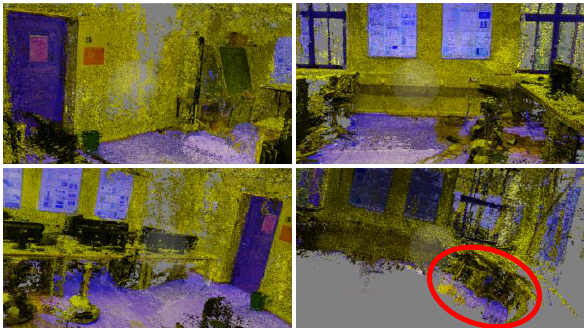
Figure 8. Excerpts from the generated point cloud using the three channel images with replaced Blue channel. It becomes clear, that the extracted categories are very well visible in the point cloud. However, in the bottom right image there is an error with the